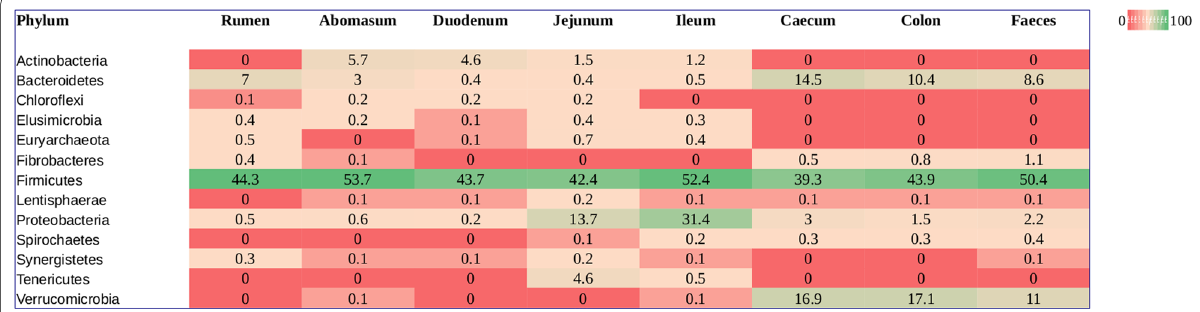
Fig. 3 Heatmap showing significant differences in bacterial abundance among gastro-intestinal tract (GIT) segments at phylum level, based on ANCOM analysis. Each value represents the median relative abundance in